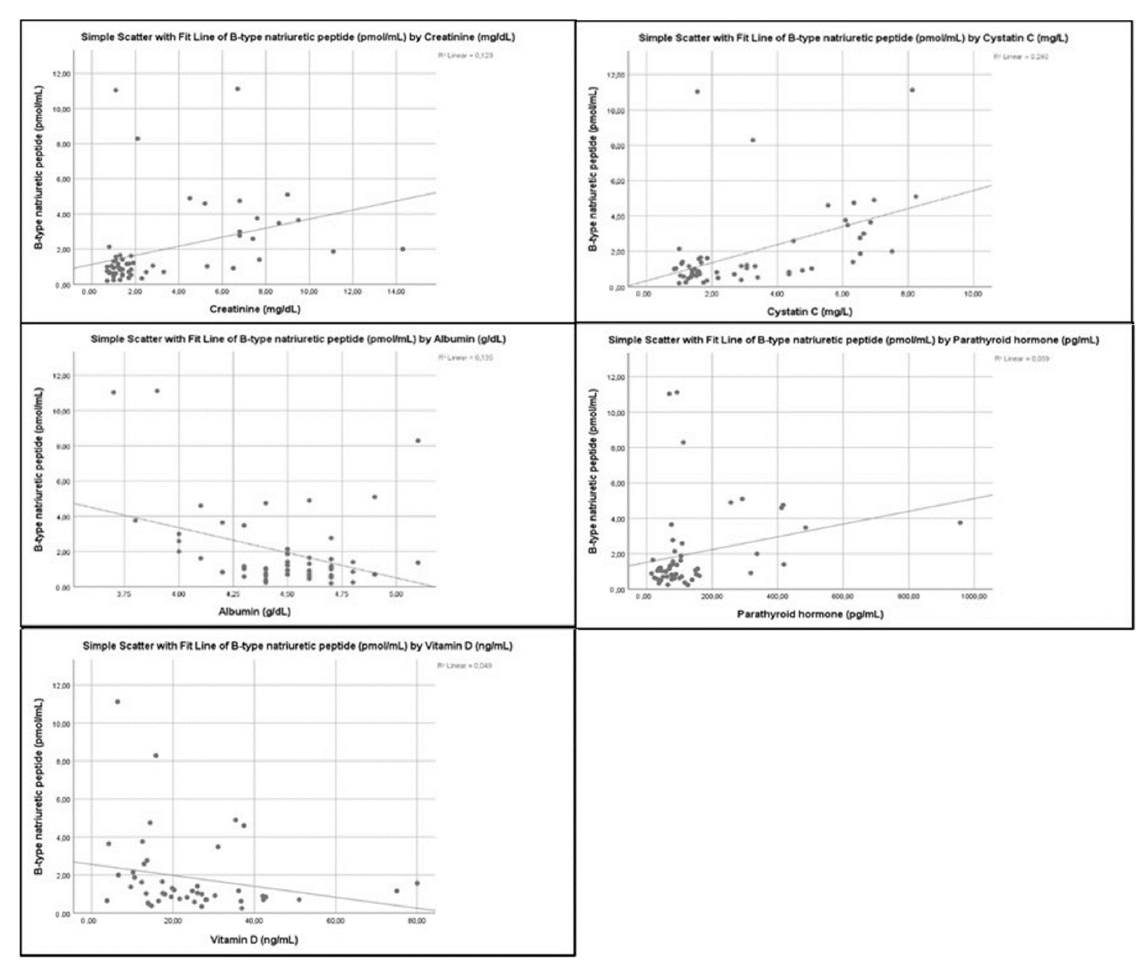
Figure 3. Correlations of plasma BNP levels with biochemical markers. was significantly inversely correlated with BNP (R2 Linear 0.104, p = 0.034 Spearman’s correlation) (Figure 4). There was no statistically significant correlation between BNP lev- els and EF ( p = 0.182), LVM ( p = 0.092), LVMI ( p = 0.950), SBP ( p = 0.955), DBP ( p = 0.230) or HR ( p = 0.113).